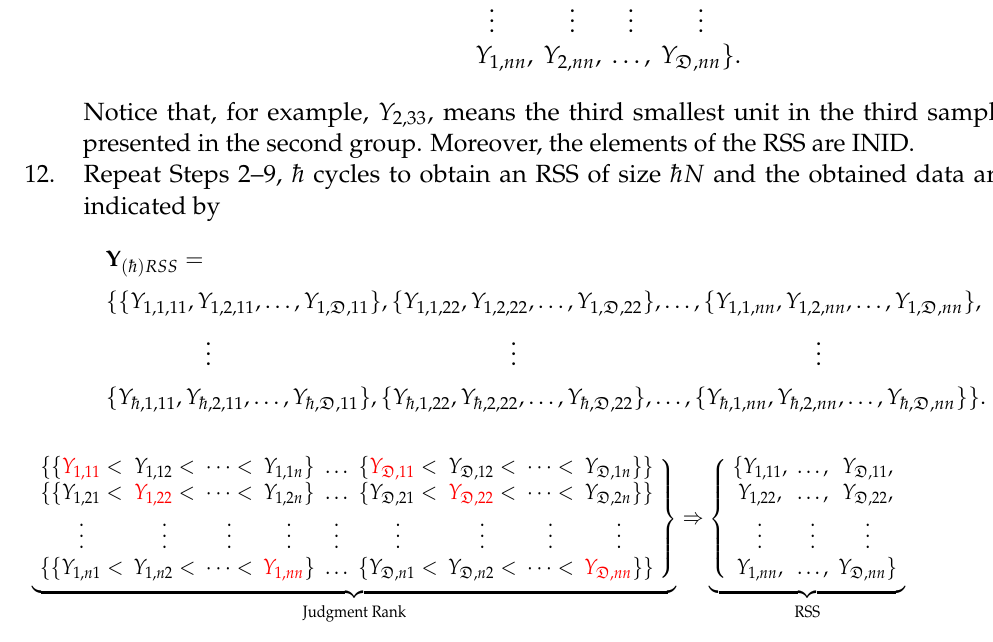
Figure 1. A ranked set sampling procedure under progressive-stress ALT with D ( > 1) levels of stress.